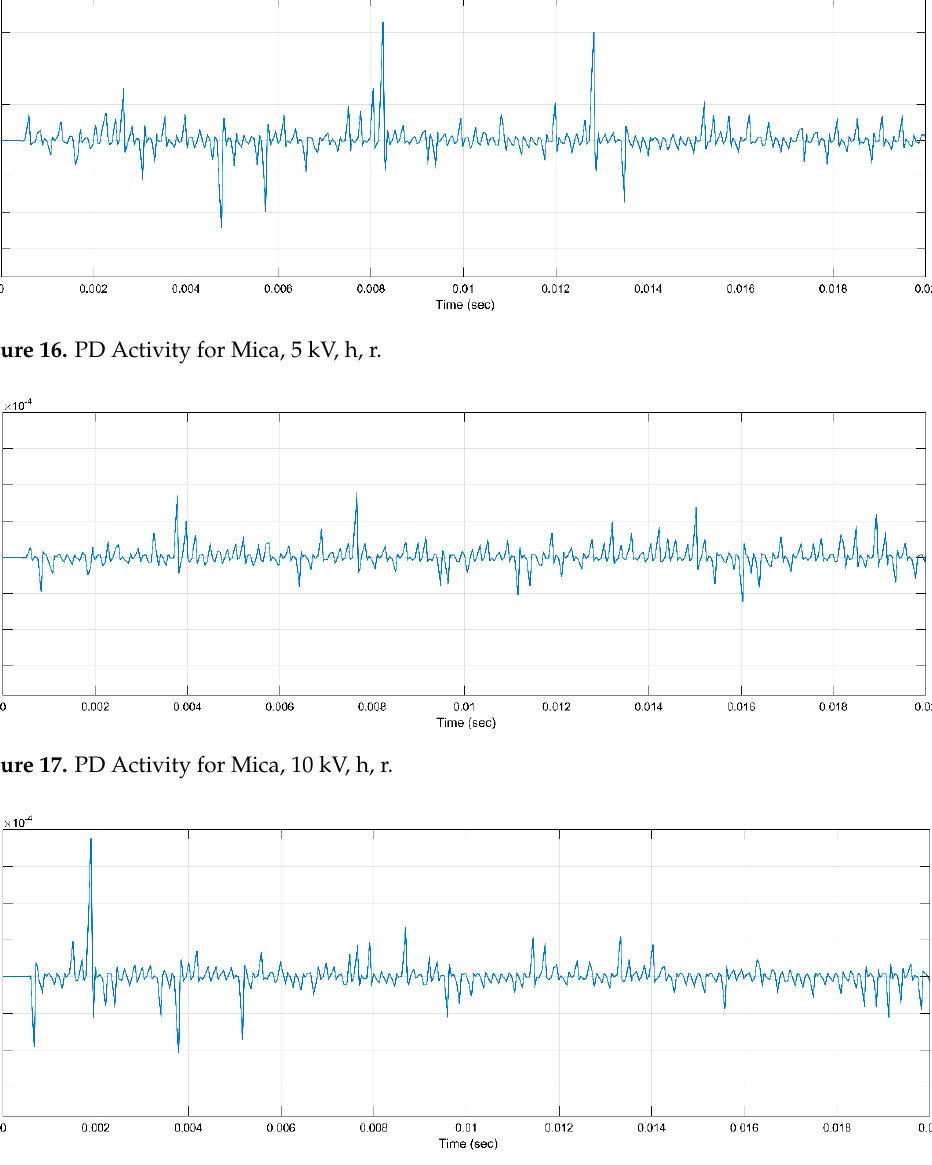
Figure 18. PD Activity for Mica, 15 kV, h, r.